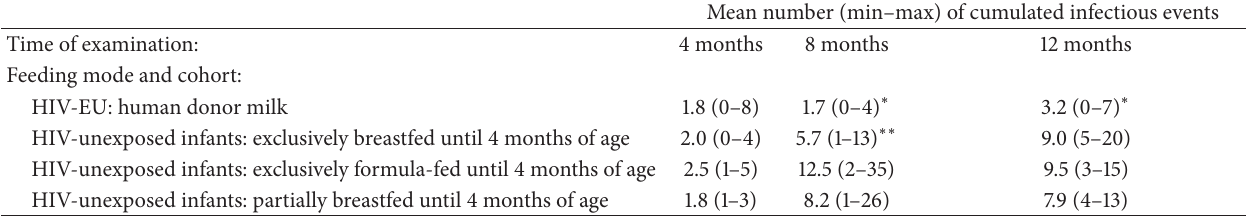
Table 4: Events of infectious illness in HIV-exposed uninfected (HIV-EU) infants compared to term HIV-unexposed infants, according to their different feeding modes at 4 months of age. The observation period between each examination was 4 months. 𝑁 is the mean number of cumulated infectious events between two evaluations per child in every feeding mode category.